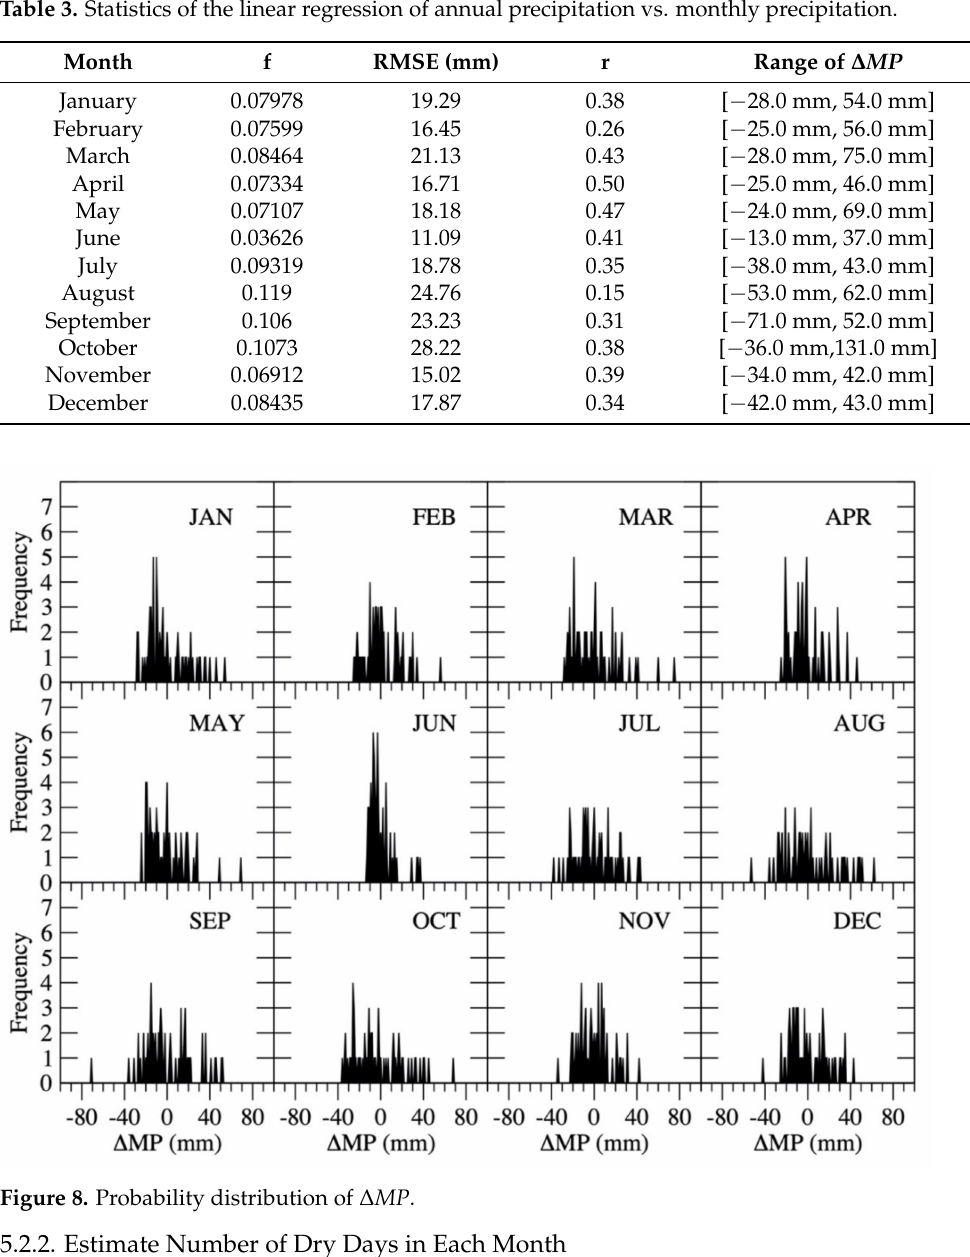
Table 3. Statistics of the linear regression of annual precipitation vs. monthly precipitation.